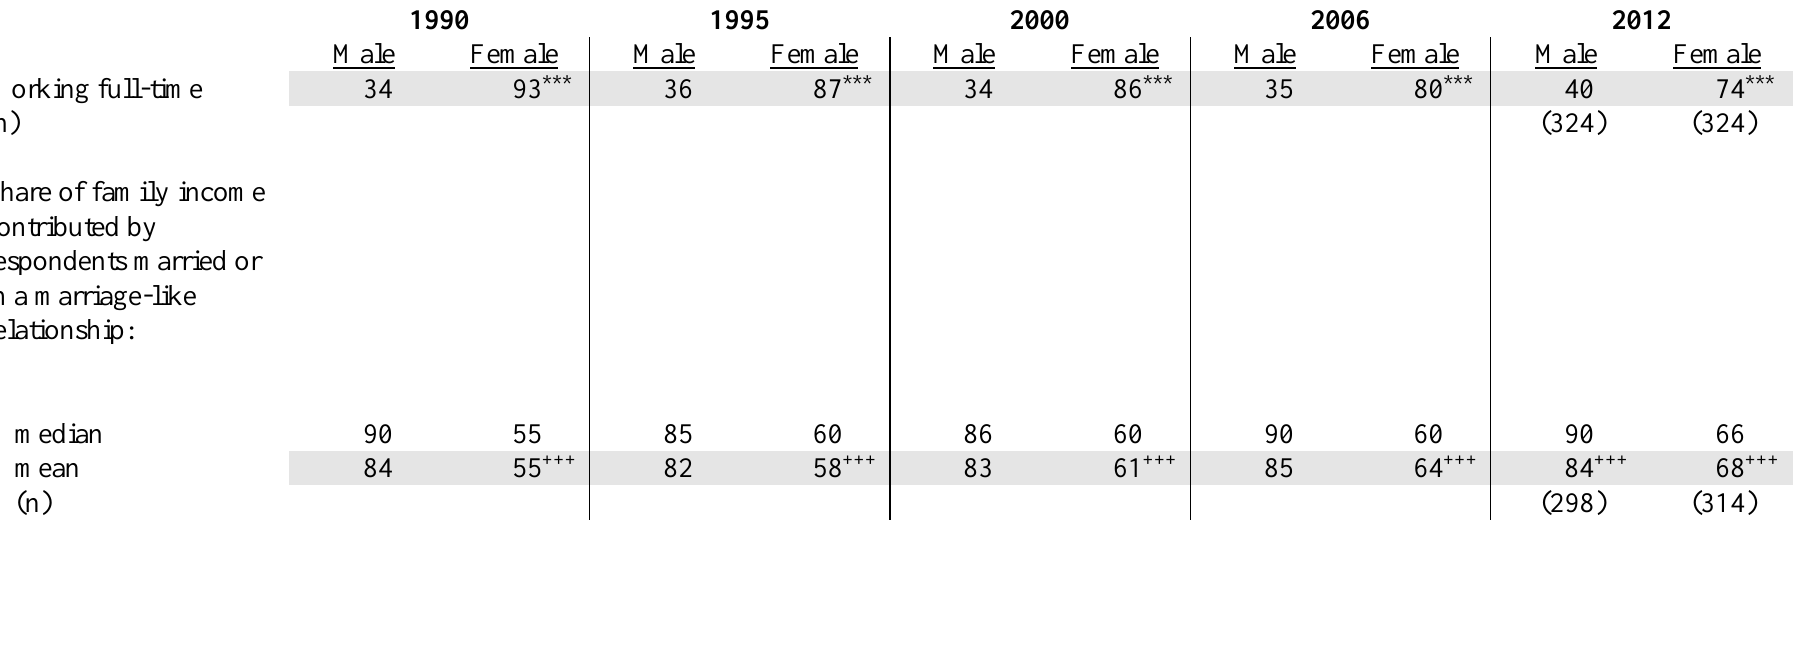
Table 18. Characteristics of Spouse/Significant Other